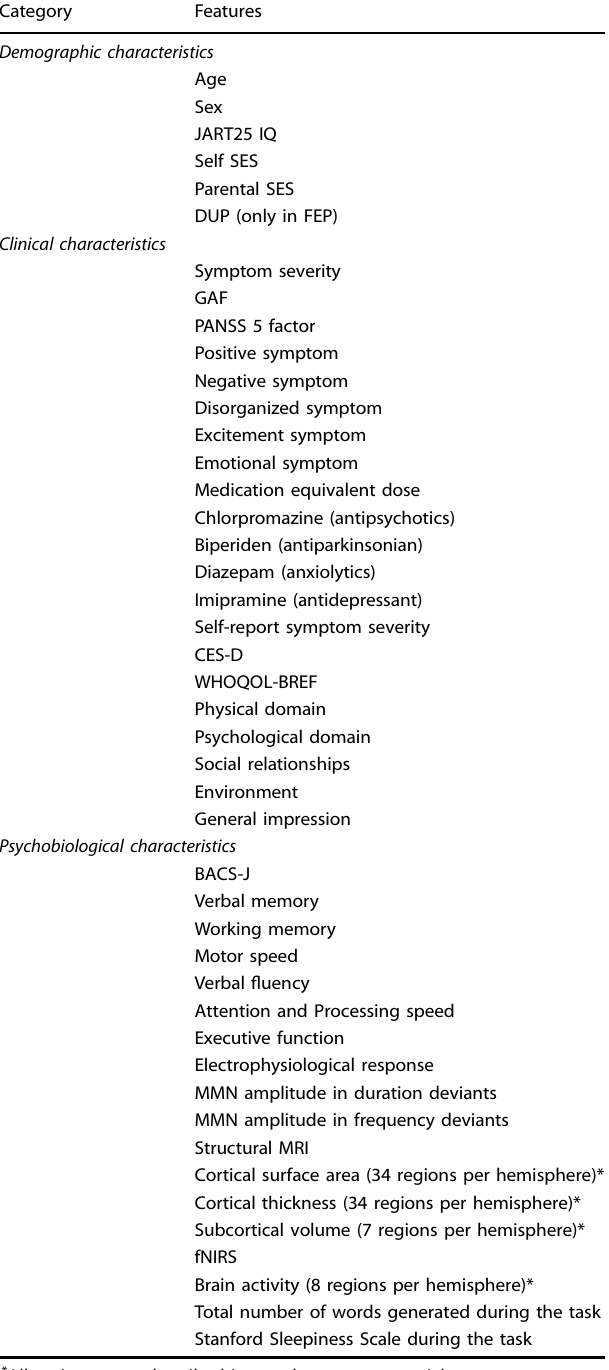
Table 2. List of demographic, clinical, and psychobiological characteristics in this study.